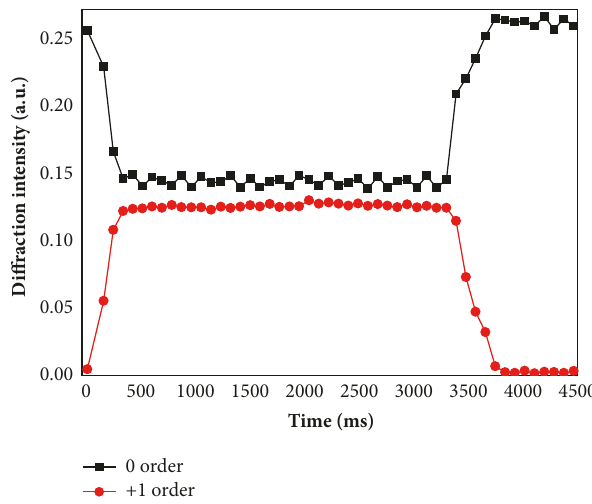
Figure 2: The diffraction intensities of the liquid crystal gratings in zeroth and the first orders were recorded as a function of time, using an applied voltage of ∼